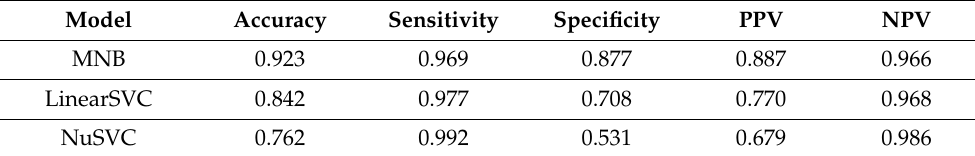
Table 13. Evaluation of the chosen classifier performance in Substage 1.